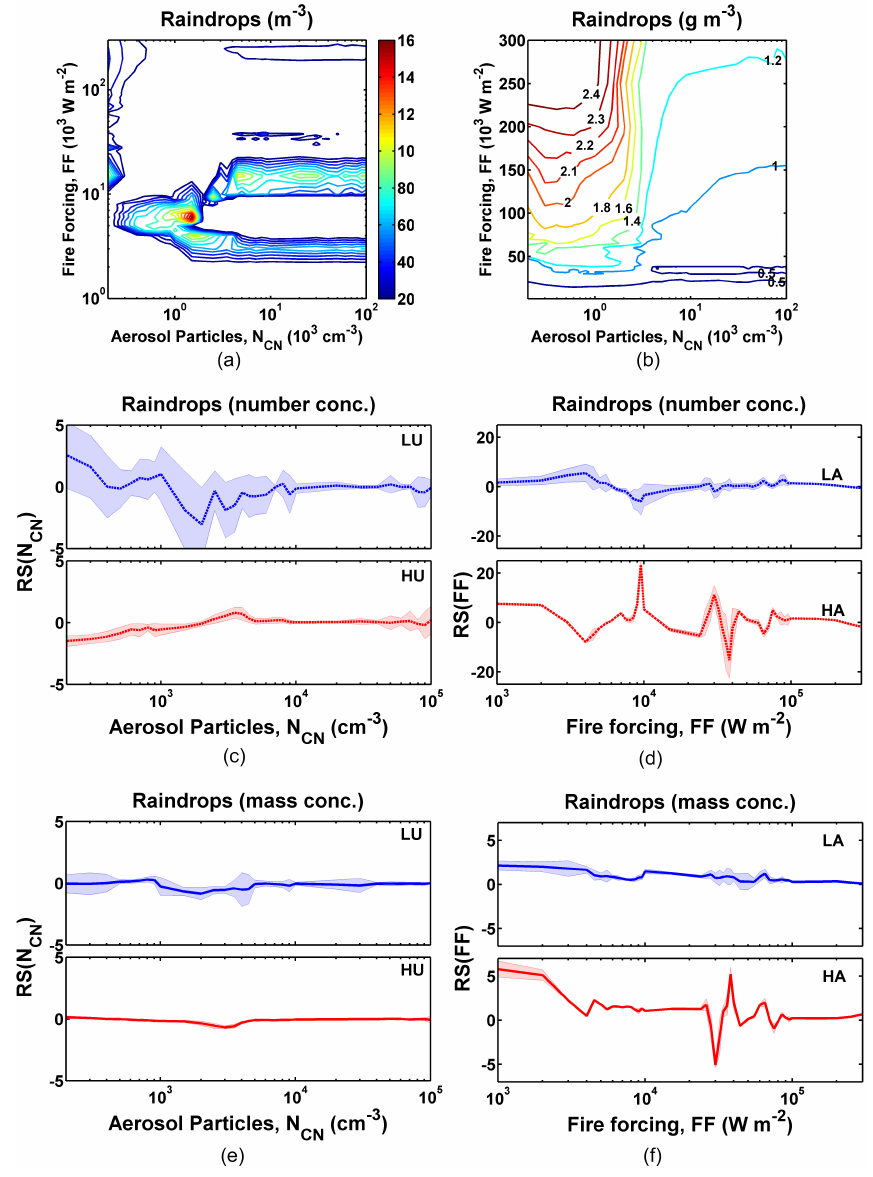
Figure 9. Same as Fig. 7 but for